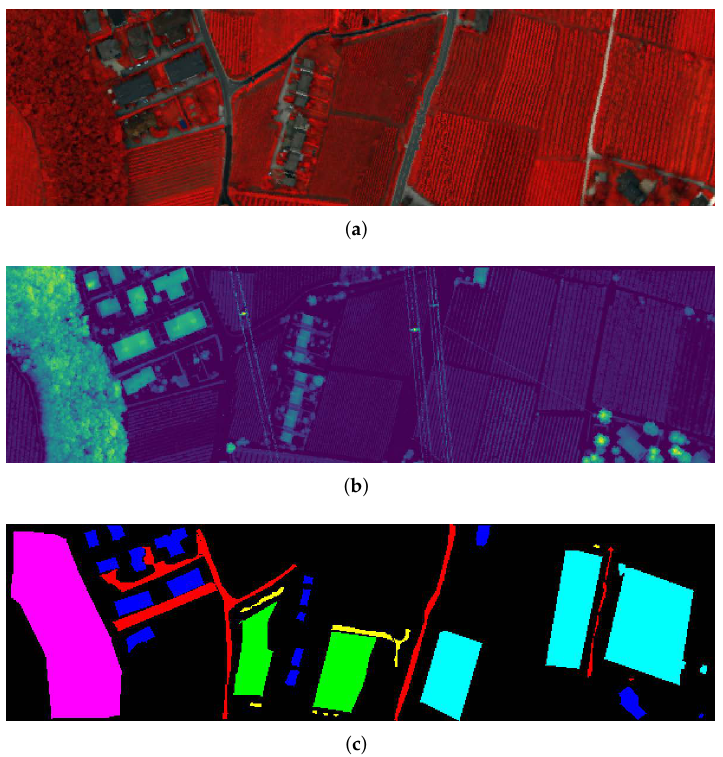
Figure 5. Visualization of the Trento Data. ( a ) False-color images of hyperspectral data using 40, 20, and 10 as R, G, B, respectively. ( b ) Gray images of LiDAR data. ( c ) Ground-truth map.